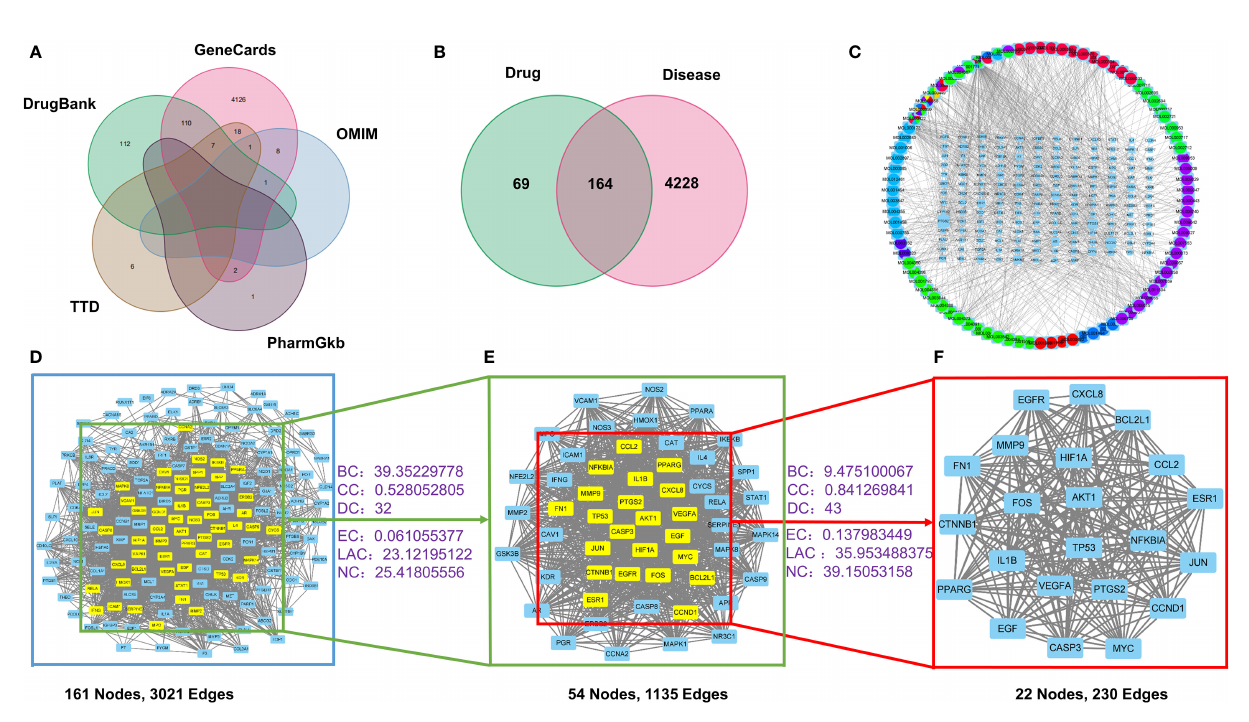
FIGURE 2 | The drug-target-disease network and PPI network construction. (A) The collection of predictive targets for OP. (B) The intersection targets of ZGBSF- related targets and OP-related targets. (C) The network of drug-target-disease includes 10 kinds of herbs, 86 active components, and 164 target genes. Circle represents active components and rectangle represents related targets. (D) PPI network of predicted targets of ZGBSF against OP. (E) The signi fi cant proteins of the PPI network were extracted from (D) . (F) Screening 22 key proteins of ZGBSF in the treatment of OP were extracted from (E)